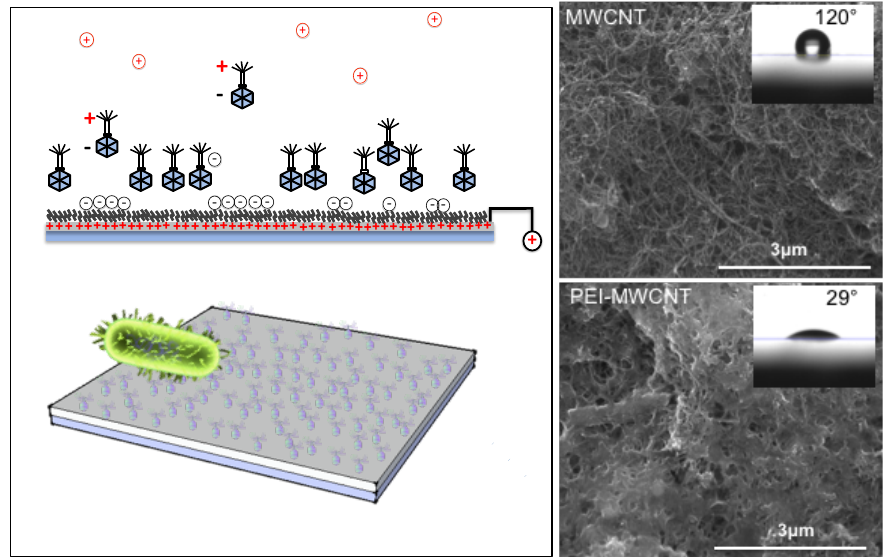
Figure 14. Schematic of the charge-directed orientation and immobilization of bacteriophages onto PEI-functionalized CNT on electrode surface, and the SEM images of CNT before and after PEI modification